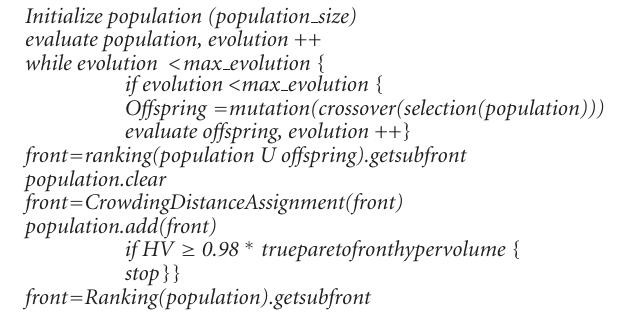
Algorithm 1: A pseudocode for NSGA II procedure.